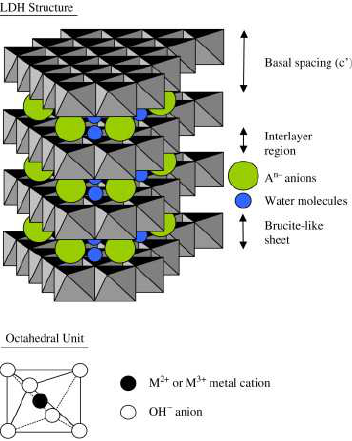
Figure 1. Structural model of LDH [40]. Copyright 2007